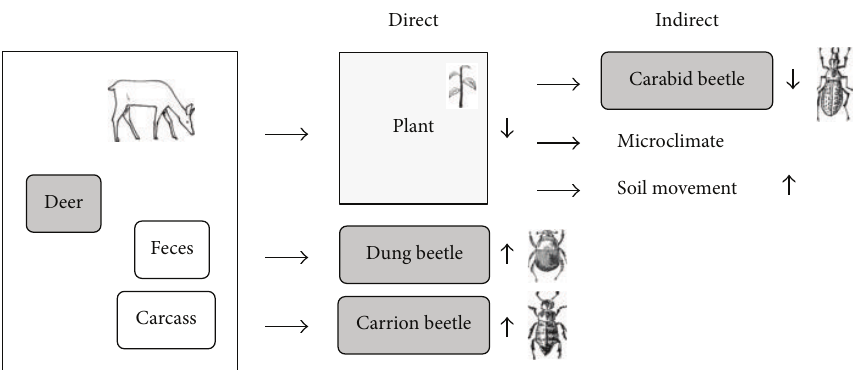
Figure 8: Summary of indirect effects of sika deer grazing on plants and decomposer insects and indirect effects on microenvironment, soil movements, and carabid beetles at Okutama, western Tokyo, Japan.